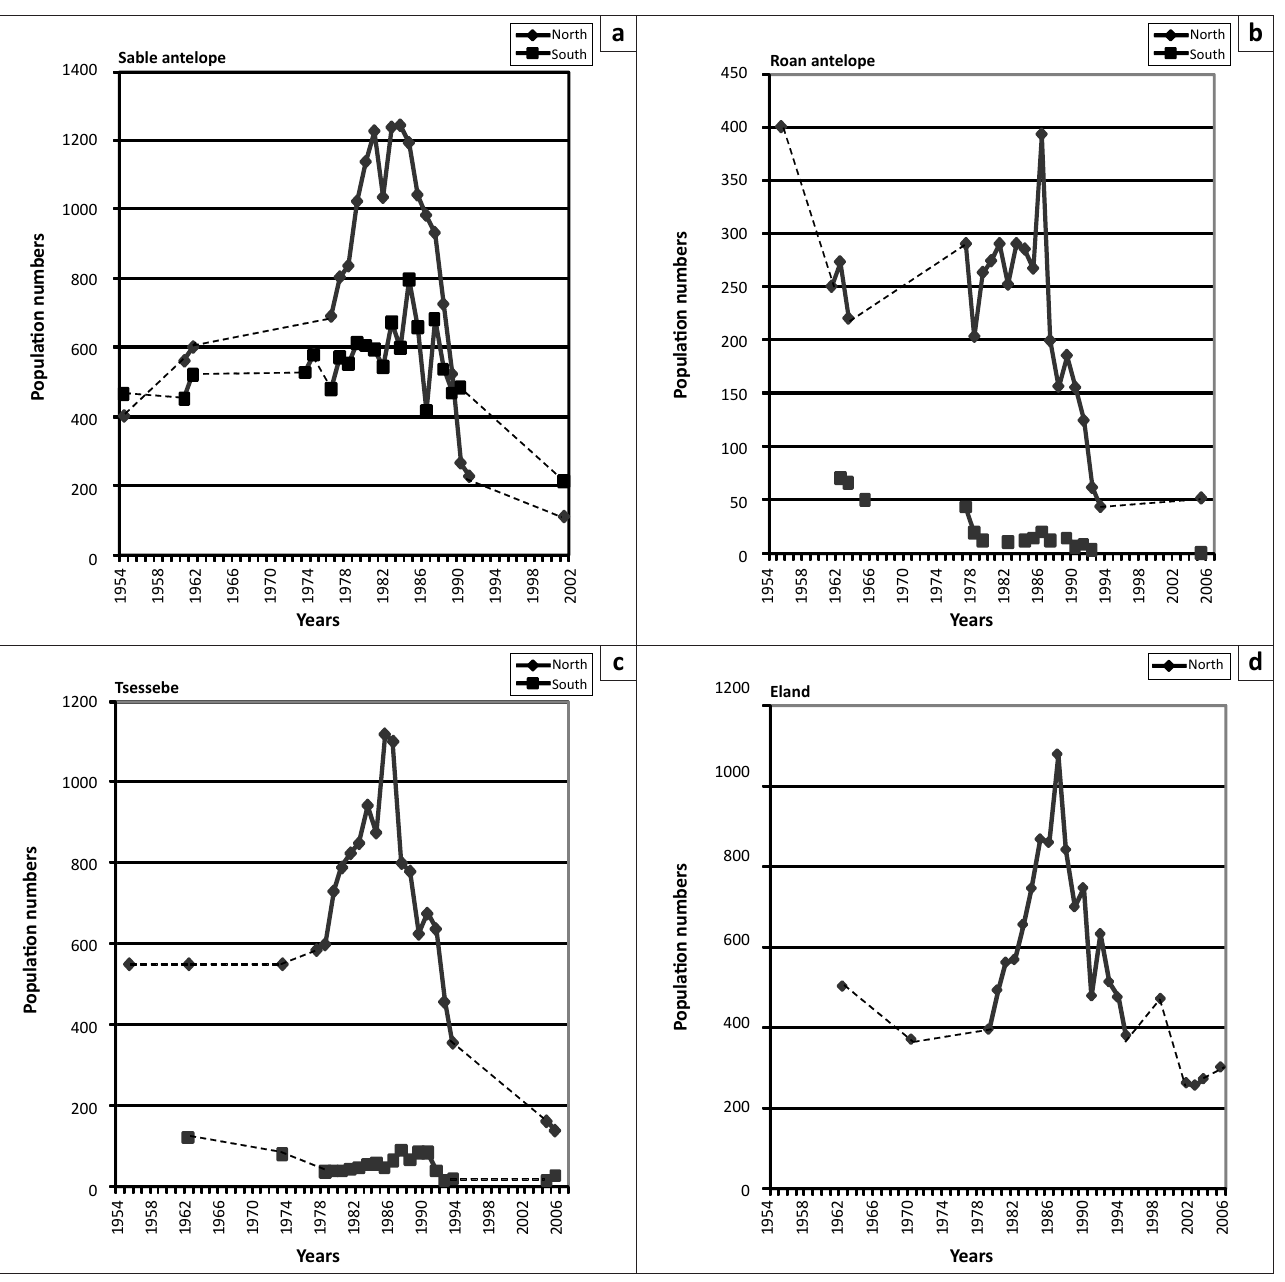
FIGURE 4: Population numbers of (a) sable antelope, (b) roan antelope, (c) tsessebe and (d) eland based on censuses carried out between 1954 and 2006 (northern and southern Kruger National